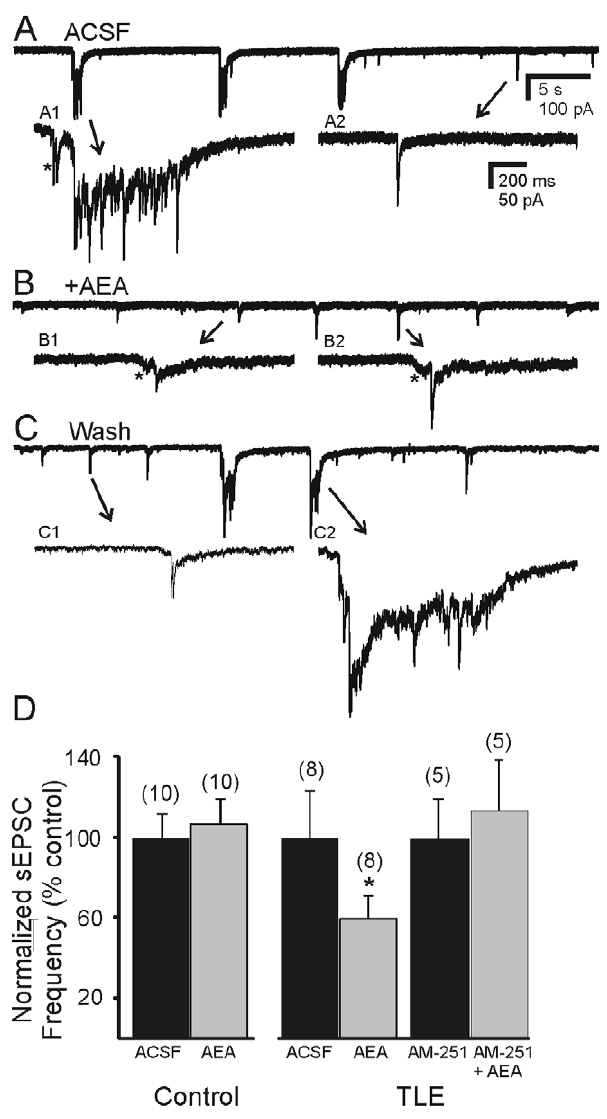
Figure 4. Inhibitory effect of anandamide (AEA) on sEPSCs. A . Spontaneous bursts of EPSCs observed in a granule cell from a pilocarpine-treated mouse that survived SE. A1 and A2 are expanded segments of the events indicated by the arrows. B . AEA (10 m M) suppressed the epileptiform bursts of activity. B1 and B2 are examples of individual events from B . C . Bursts were reinstated after 20 minute wash to normal ACSF. C1 and C2 , expanded segments of C . Asterisks indicate currents preceding the largest amplitude EPSCs in some cases. The recordings were made in the absence of Mg 2 + and the presence of bicuculline (30 m M). D . Cumulative graph of normalized sEPSC frequency from control mice and pilocarpine-treated mice that survived SE and developed TLE before and after application of AEA. Asterisk in D indicates significant reduction in frequency by AEA (P , 0.05). In mice with TLE, the effect of AEA was prevented by preapplication of the CB1 receptor antagonist AM-251 (10 m M). Number of cells for each experiment is in